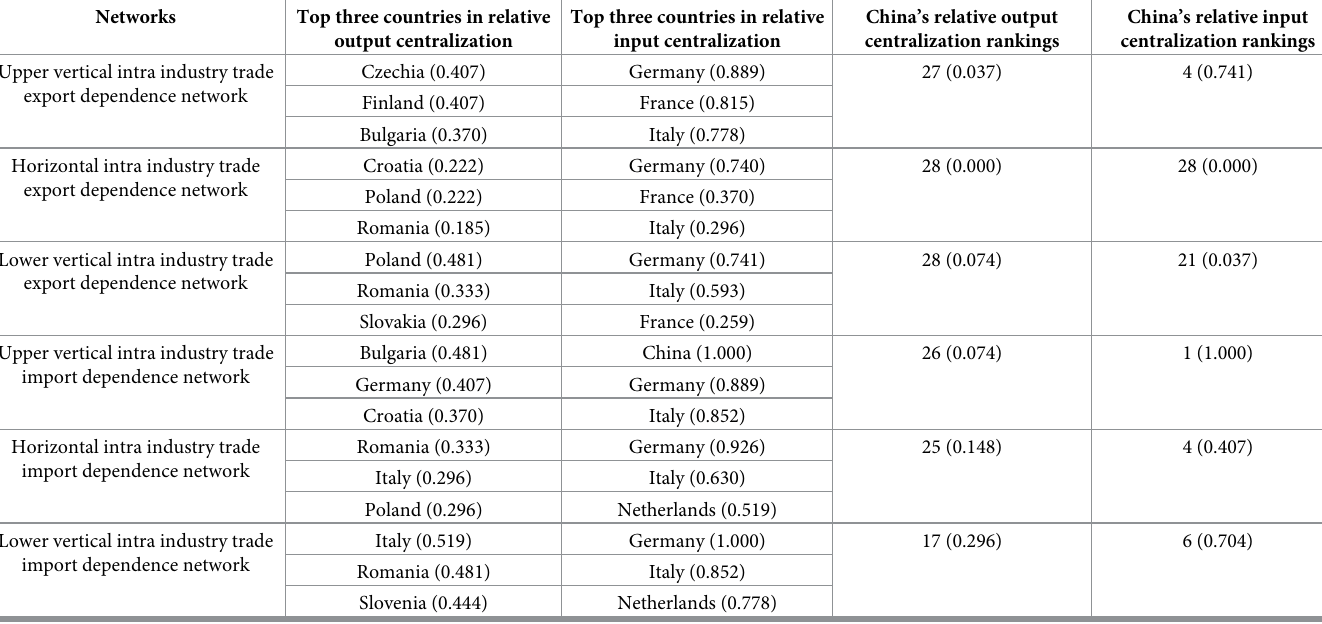
Table 3. Analysis on the centrality of China-EU equipment manufacturing trade network in 2020.